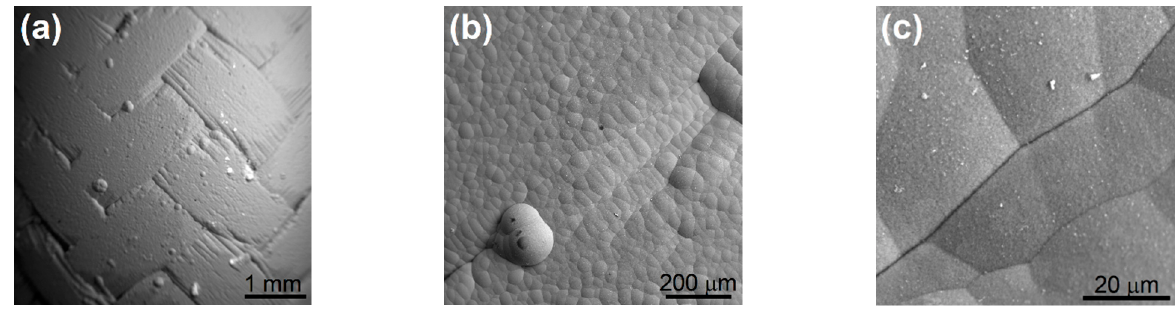
Figure 4. SiCf/SiC sample: CVR SiC L2-17C roughness (Ra ~ 10 μ m) after HT helium exposure at 900 °C, 90 m/s for 500 h (same zone, different magnification ( a – c ).